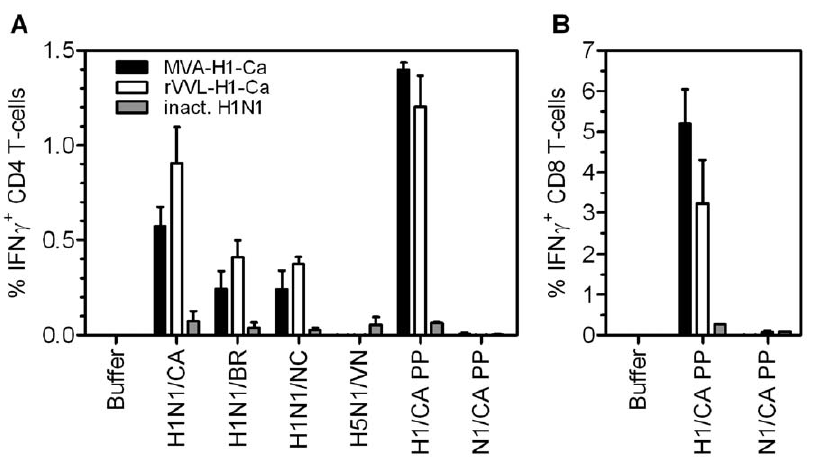
Figure 4. T cell induction by the hemagglutinin expressing live vaccines. A ) Frequencies of influenza antigen specific IFN- c + CD4 T cells after immunizing two times with hemagglutinin constructs MVA-H1-Ca (black bars), rVVL-H1-Ca (white bars) or inactivated vaccine (grey bars) and stimulation with different antigens and peptides (shown on x-axis). Splenocytes were stimulated with buffer and with protein antigens (formalin- inactivated monovalent bulk material) of the influenza strains H1N1 California (H1N1/CA), H1N1 Brisbane (H1N1/BR), H1N1 New Caledonia (H1N1/NC), H5N1 Vietnam 1203 (H5N1/VN) and with peptide pools of overlapping 15-mer peptides of the swine flu hemagglutinin (H1/CA PP) or neuraminidase (N1/CA PP) antigens. B ) Frequencies of influenza hemagglutinin-specific IFN- c + CD8 T-cells after two dosages of vaccine. Splenocytes were stimulated with the peptide pools indicated above. The data are mean values ( + / 2 SEM) of two independent experiments.